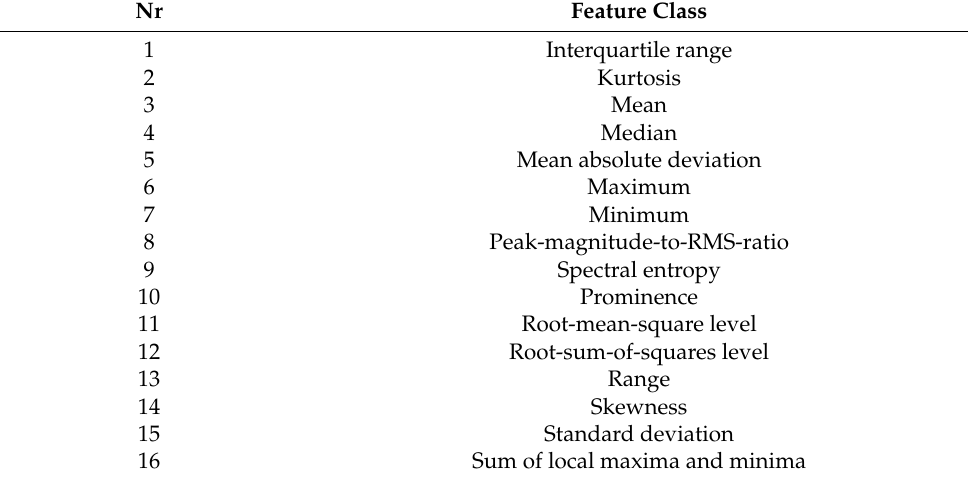
Table 3. Feature